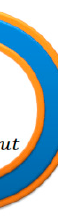
thickness of the hydrophobic membrane and 𝑅 (cid:3042)(cid:3048)(cid:3047) is the outer radius. of the hydrophobic membrane and R out is the outer radius.